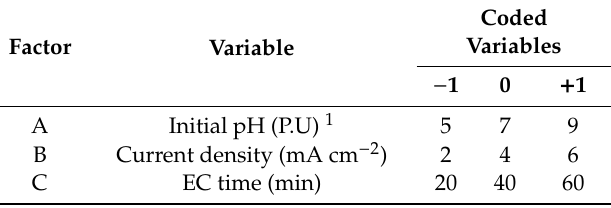
Table 1. Independent variables and their levels.